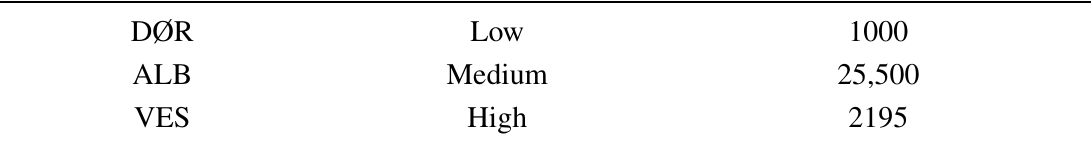
Table 1. The Danish wind farms used in this